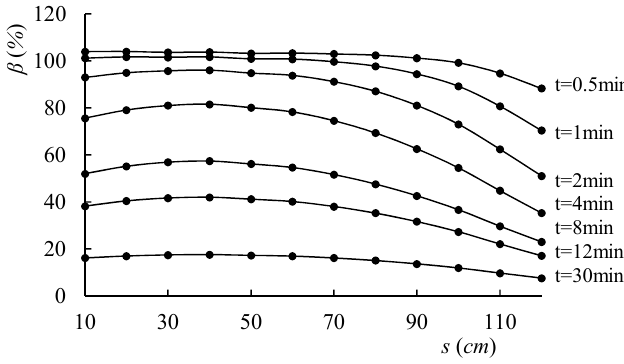
Figure 5. The effective storage rates (ESR) ( β )—distance (s) relationship curves.